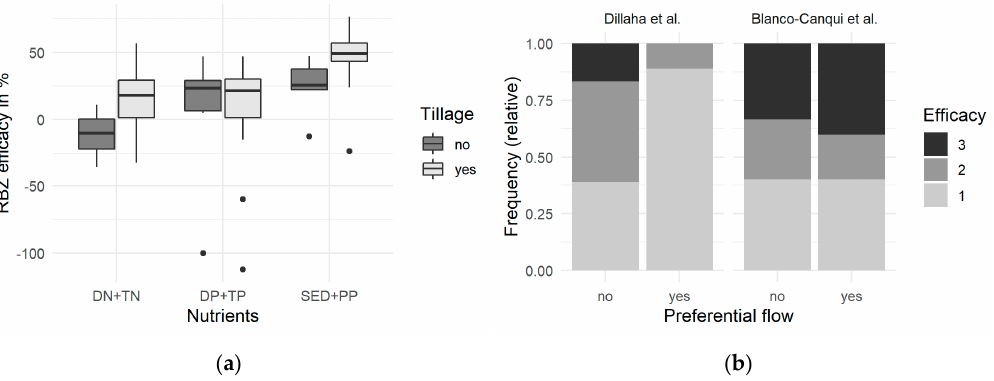
Figure 9. Examples of non-representative and inconsistent effects on RBZ efficacy, ( a ) tillage (data from references [74,76,83,84] , paired n = 30), ( b ) preferential flow (left: data from references [78,85] , right: data from [86] , without switchgrass barrier, paired n = 6).